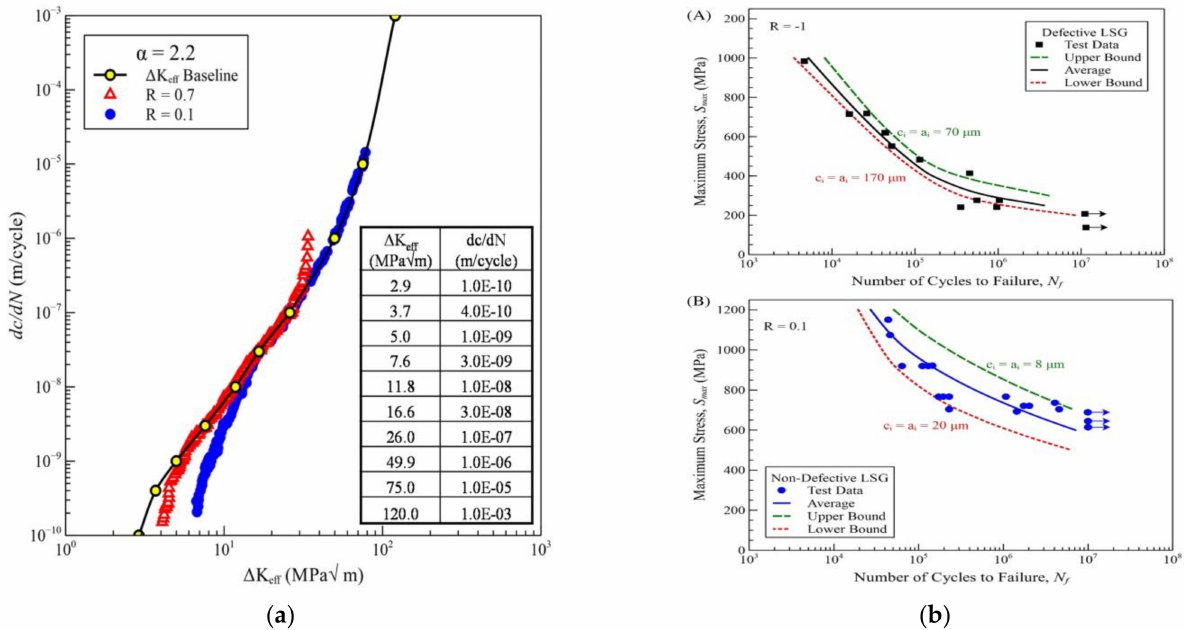
Figure 10. ( a ) Effective stress intensity factor against crack growth rate for large cracks with a small- crack estimate for L − PBF Inconel 718; ( b ) Effect of void size on fatigue life of ( A ) defective and ( B ) non-defective builds L − PBF Inconel 718. Reprinted with permission from ref. [70]. 2018, Wiley.